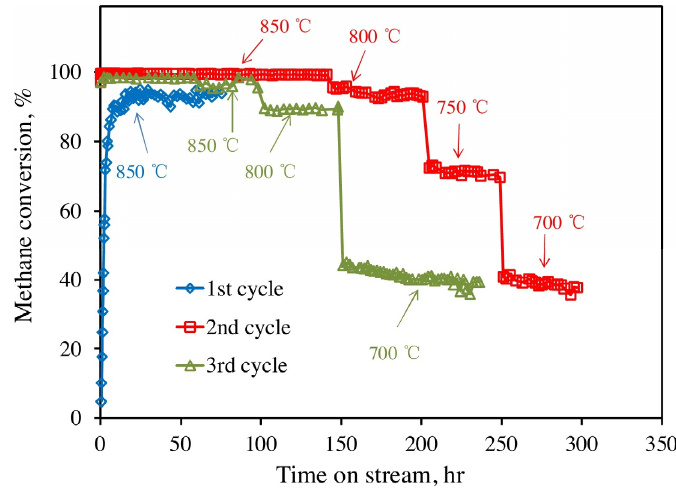
Figure 8. CH 4 conversion of DRM catalyzed by atomic layer deposition (ALD)-prepared Ni nanoparticles on mesoporous alumina at different temperatures (700~850 ◦ C) (denoted as ALD Ni/ γ -Al 2 O 3 in Ref. [85]). Reprinted with permission from Ref. [85]. Copyright (2017) Elsevier.